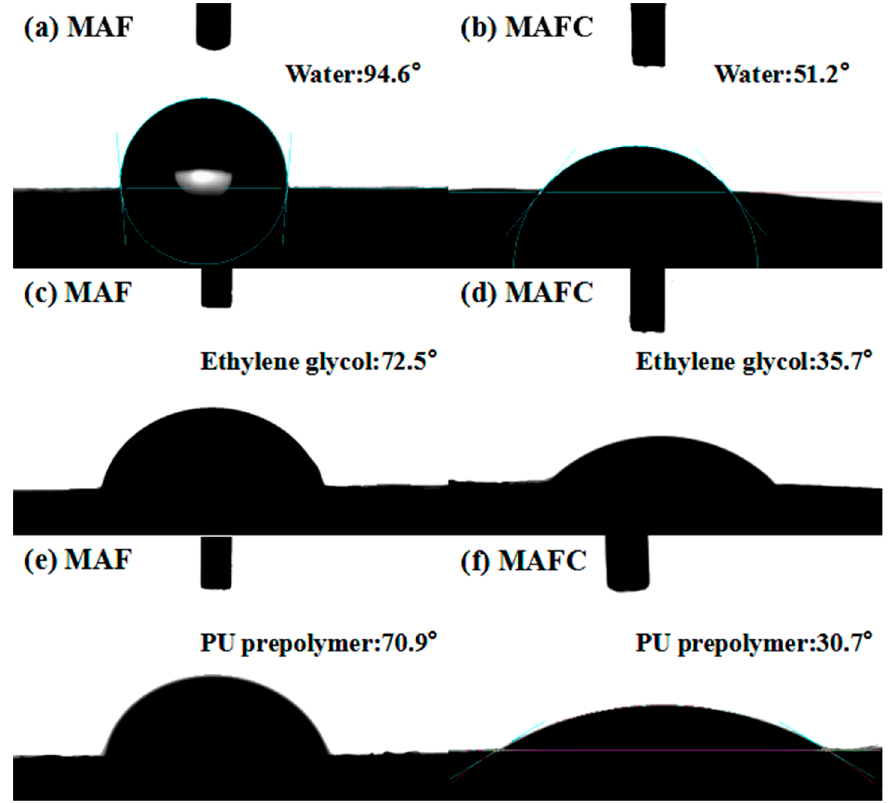
Figure 5. Water, ethylene glycol, and PU prepolymer contact angles of ( a ), ( c ), ( e ) MAF and ( b ), ( d ), and ( f ) MAFC.